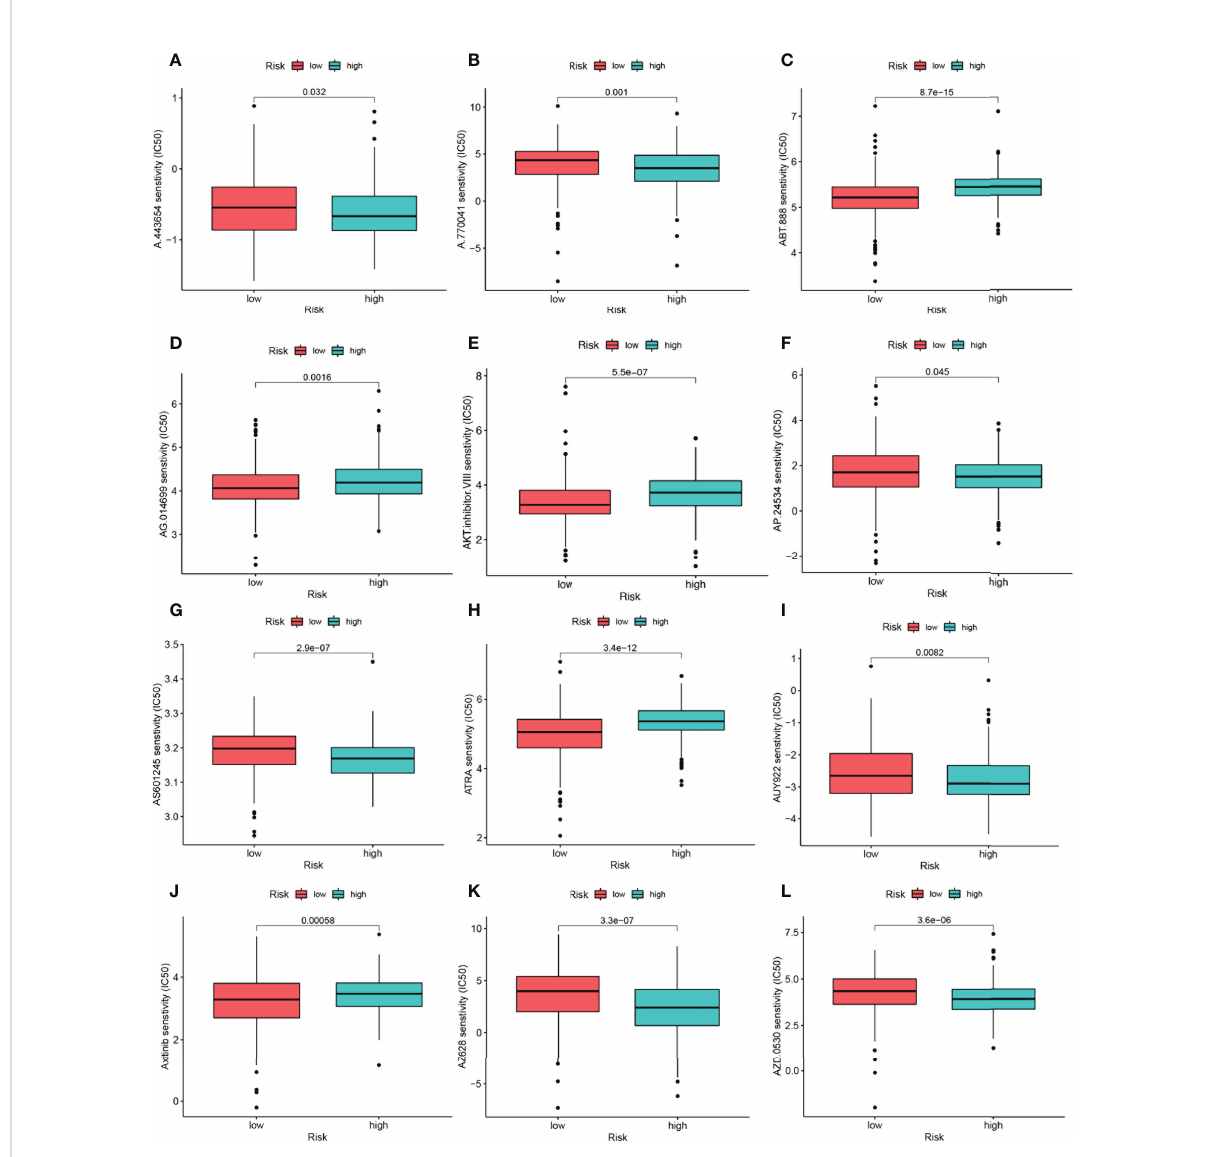
FIGURE 9 17-NRGs signature predicts chemotherapy sensitivity. (A) A.443654, (B) A.770041, (C) ABT.888, (D) AG.014699, (E) AKT.inhibitor. VIII, (F) AP.24534, (G) AS601245, (H) ATRA, (I) AUY922, (J) Axitinib, (K) AZ628, (L)